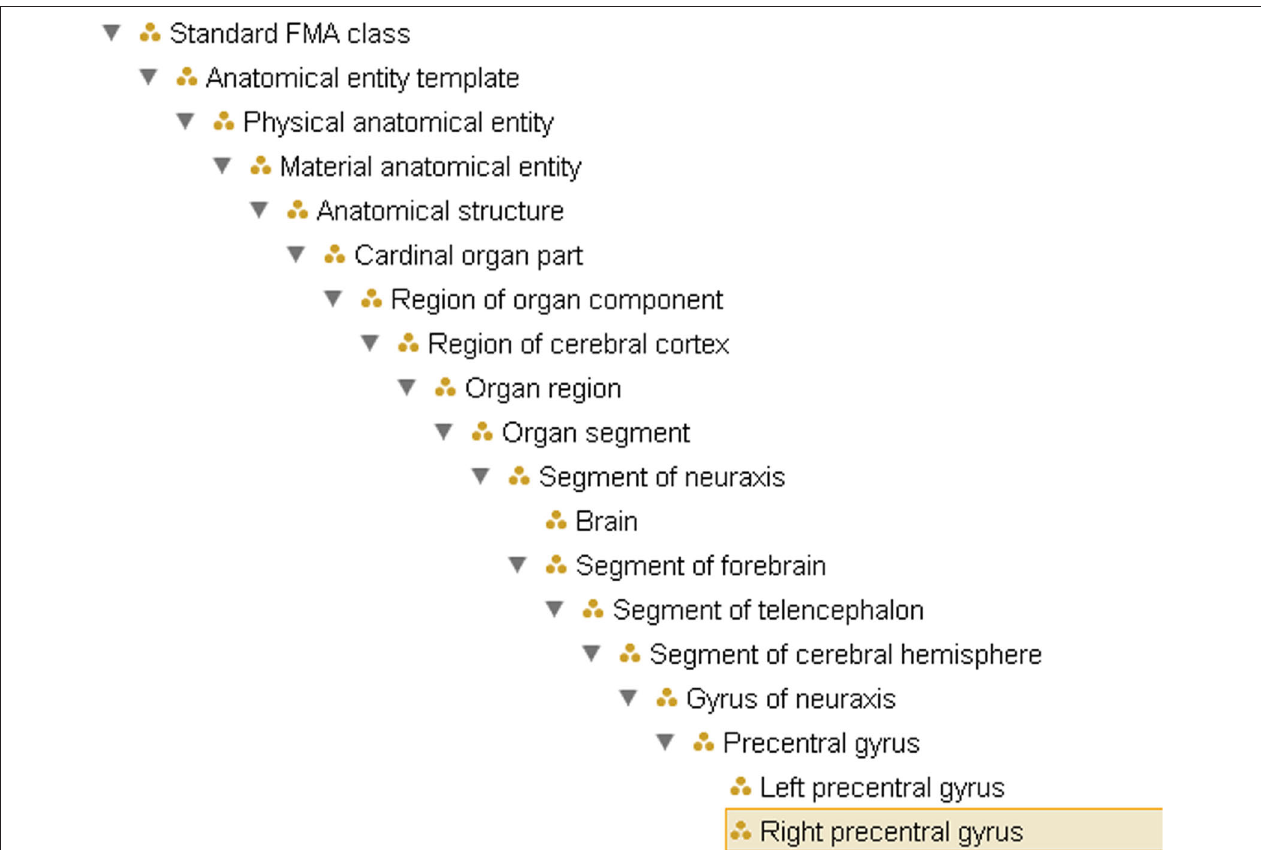
Figure 1 | example of the ontological hierarchy within FMA, representing the subclass ( is_a ) hierarchy from Right precentral gyrus to the root node of the ontology. This does not reflect the partonomy (cf. Figure 2